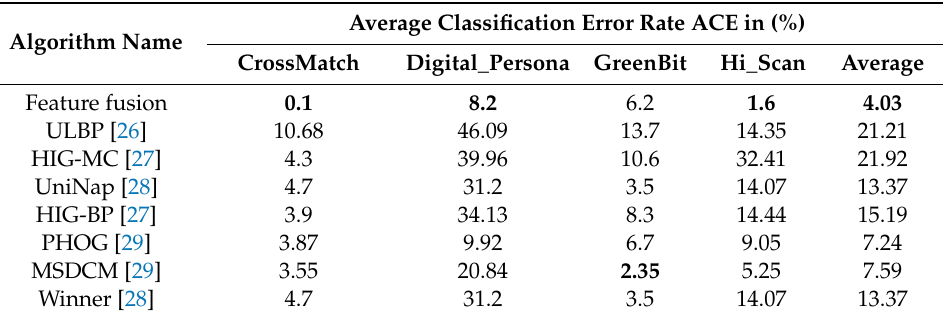
Table 11. The comparisons of the ACE of di ff erent algorithms in LivDet 2015